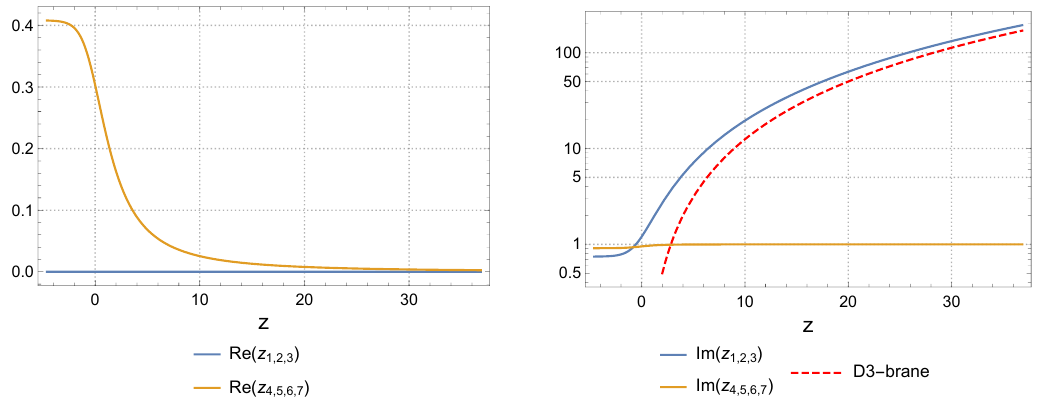
Figure 2 . Holographic RG flow from N = 4 SYM 4 (UV, right) to N = 1 & SU (3) J-fold CFT 3 (IR, left) with Λ = − 1 and λ = 0